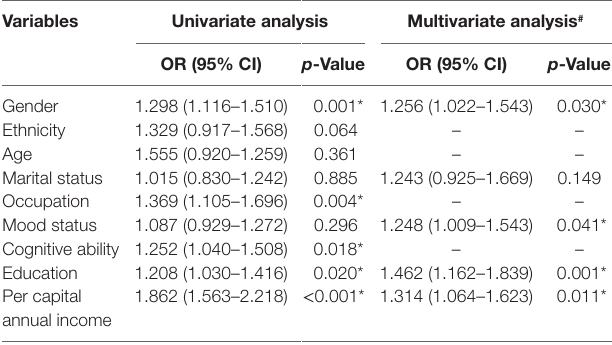
Table 3 | Univariate and multivariate logistic regression analyses of variables associated with dementia literacy.